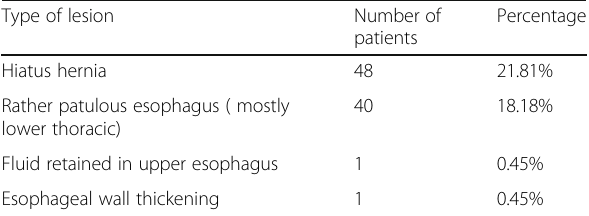
Table 5 Summary of esophageal lesions